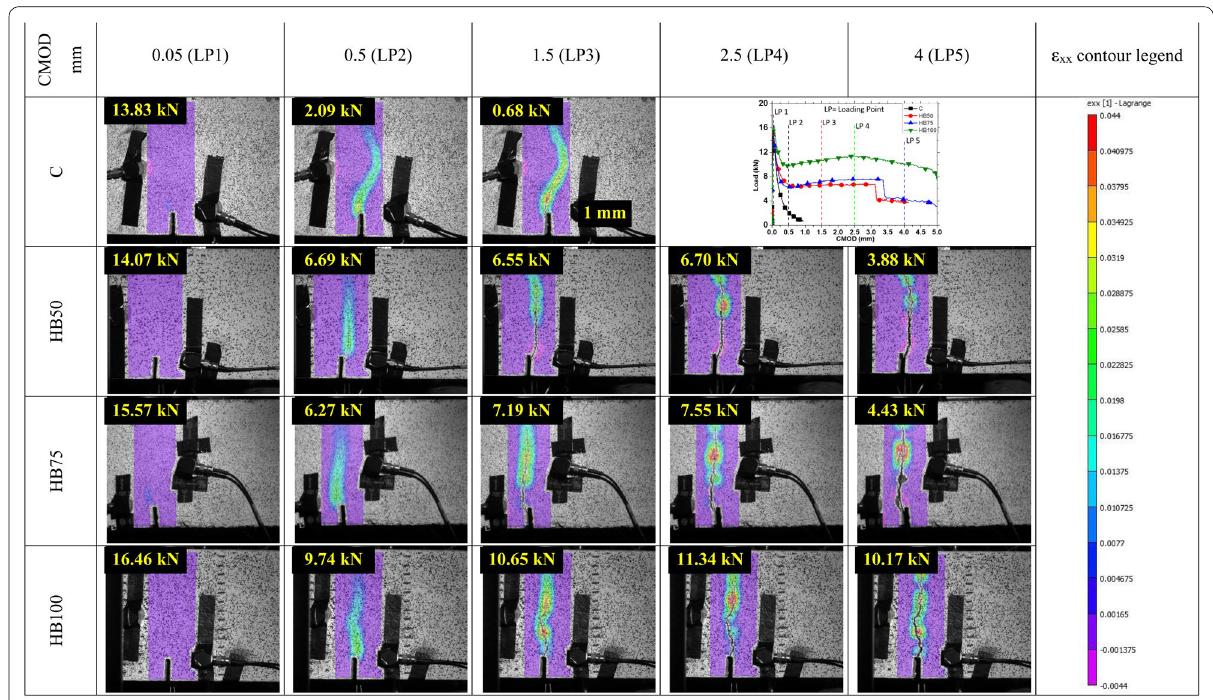
Fig. 10 Comparison of strains of HFRC with different fibre dosages at considered CMODs.